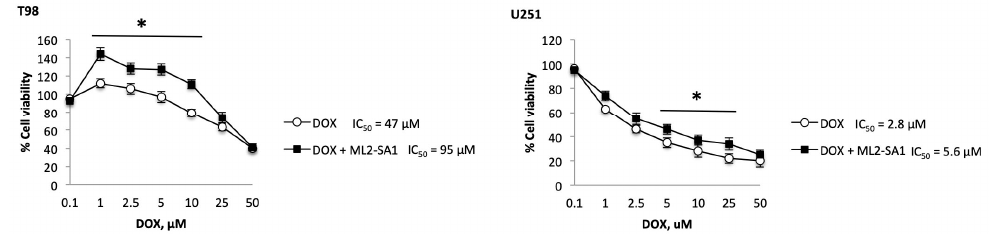
Figure 6. ML2-SA1 treatment affects the DOX (Doxorubicin)-resistance in T98 and U251 cell lines. Cell cytotoxicity was evaluated by 3-(4,5-dimethylthiazol-2-yl)-2,5-diphenyltetrazolium bromide (MTT) assay in glioma cell lines, treated with DOX at different doses for 24 h after the pretreatment with ML2-SA1 for 6 h. Data shown are expressed as the mean ± SE of three separate experiments. * p < 0.05.